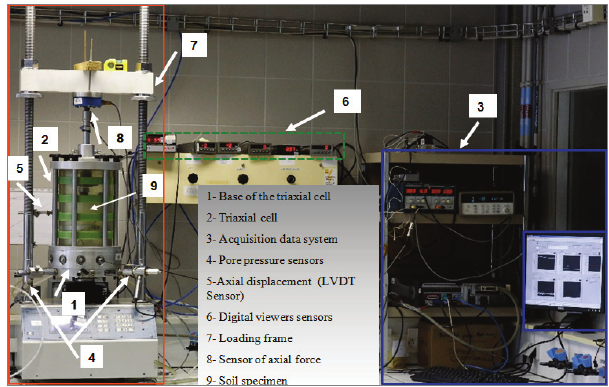
Fig. 5. View of experimental device